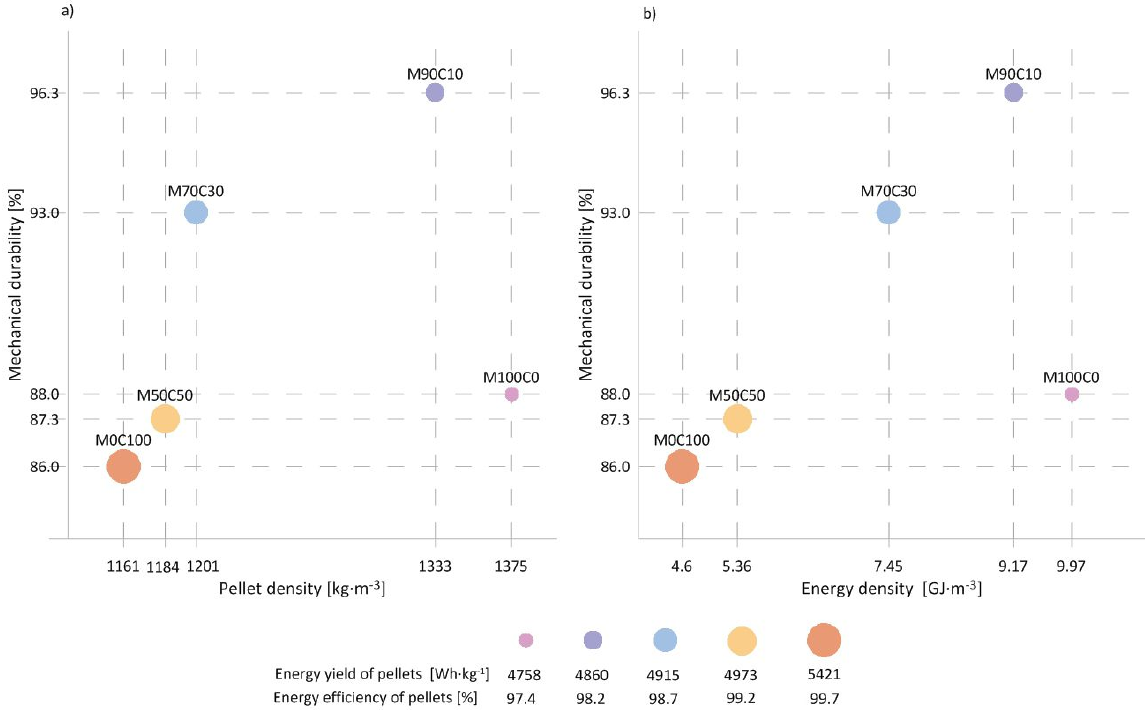
Figure 4. Energy efficiency (EE) and energy yield (EY) of pellets vs. mechanical durability: ( a ) pellet density and ( b ) energy density. Individual bubbles are assigned both the EE and EY values as shown in the legend.